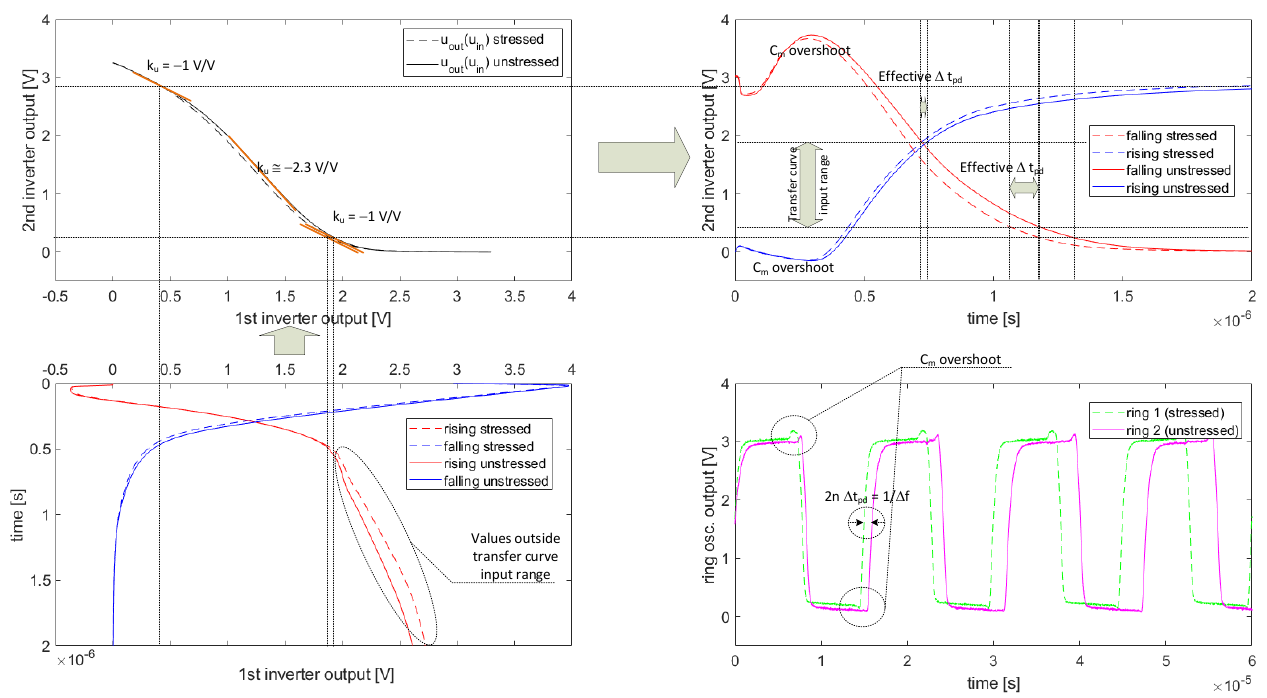
Figure 20. ∆ t pd masking